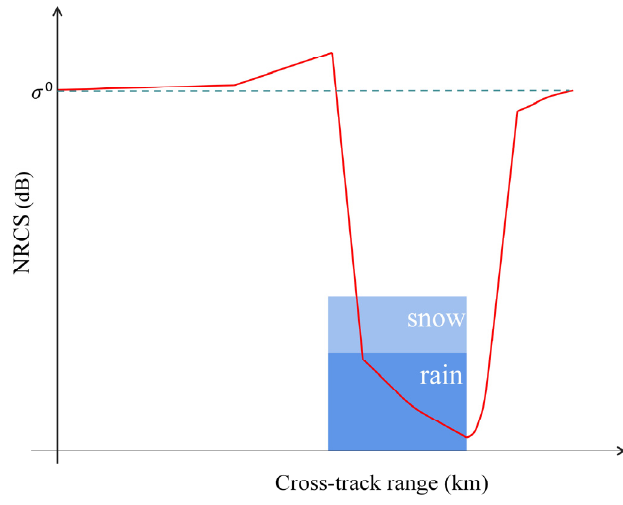
Figure 2. The NRCS simulation result.